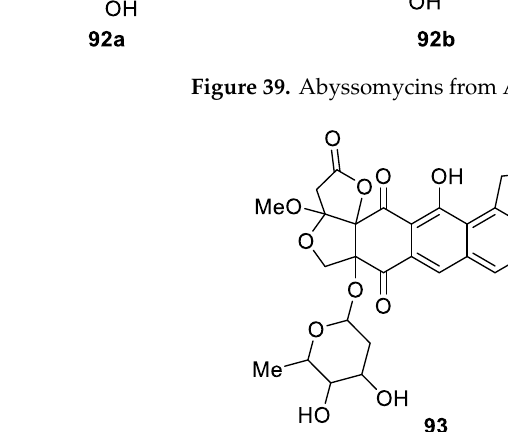
Figure 39. Abyssomycins from Actinobacteria.